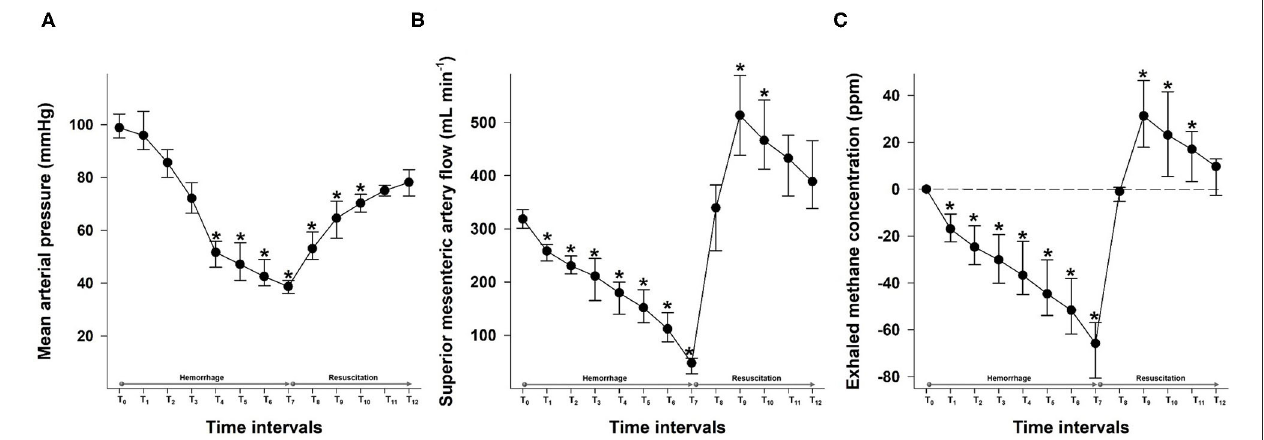
FIGURE 2 | Changes in mean arterial pressure (mmHg) (A) , the superior mesenteric artery flow (ml min − 1 ) (B) , and exhaled methane levels (ppm) (C) during the hemorrhage and resuscitation phases. The plots demonstrate the median and the 25th (lower whisker) and 75th (upper whisker) percentiles. * p < 0.05 within group vs. baseline